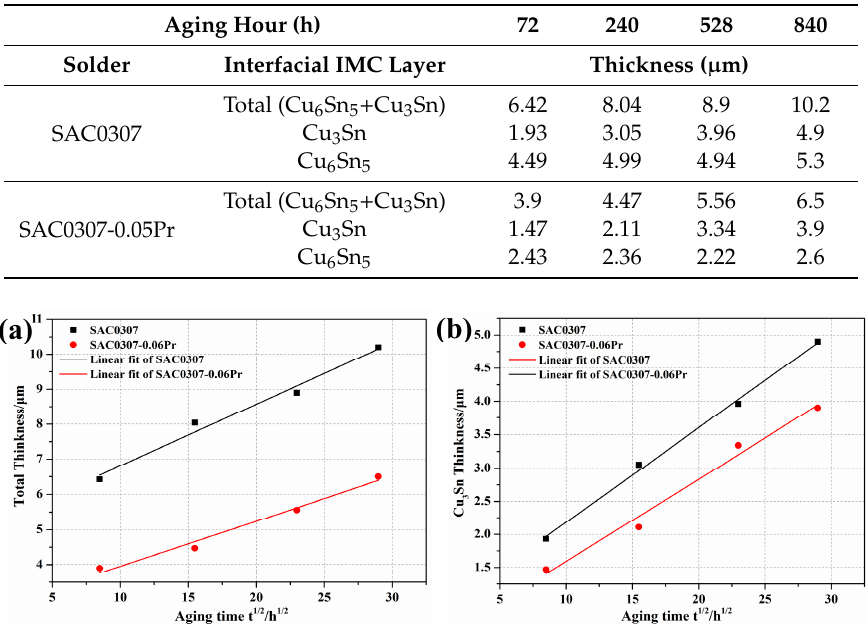
Figure 6. Thickness of the ( a ) total interfacial IMC layers (IMLs) and ( b ) Cu 3 Sn IML at ( a ) SAC0307 solder/Cu interface and ( b ) SAC0307-0.05Pr solder/Cu interface aged at 150 °C for different hrs. Table 2. Detailed thickness change with aged time at the interfaces of solders/Cu.